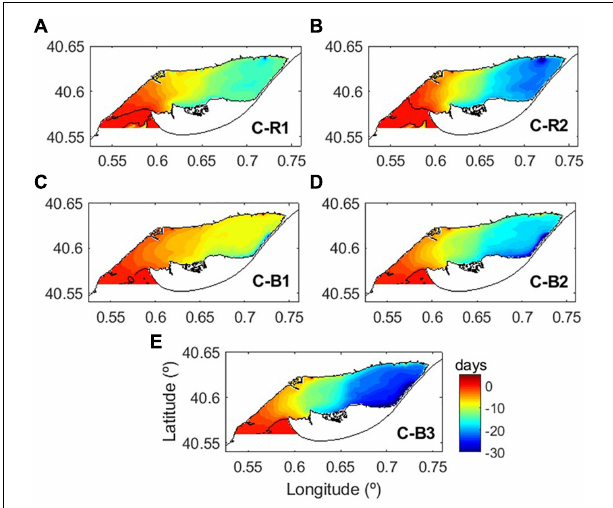
FIGURE 14 | Differences (in days) for bay water renovation, in terms of e-flushing times, when applying different interventions (all based on natural bay functioning) to the Southern Ebro Delta bay, a microtidal environment in the NW Mediterranean. All plots depict the control run (without any intervention) minus the run with intervention, which can be of three types: (1) pulsed land discharges with different discharge rates, named R1for low and R2 for high flow discharges (A,B) ; (2) transient connections to open sea with beach breaching of different widths, named B1 for narrow, B2 for medium and B3 for wide breaching (C–E) . The color scale indicates the variation in renovation times (in days), where negative/positive values indicate shorter/longer e-flushing times due to the intervention (compared to the control